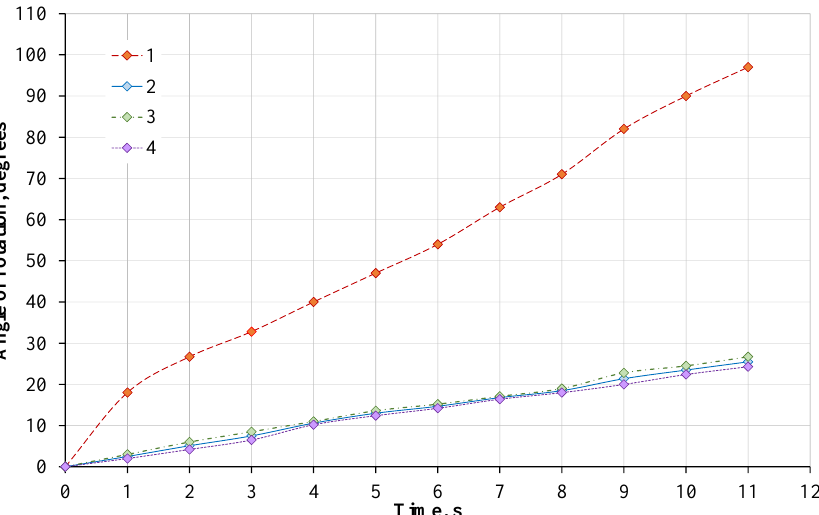
leaflets made of paper (26.7 ± 1.4 ◦ ) and transparent film (24.3 ± 1.2 ◦ ).